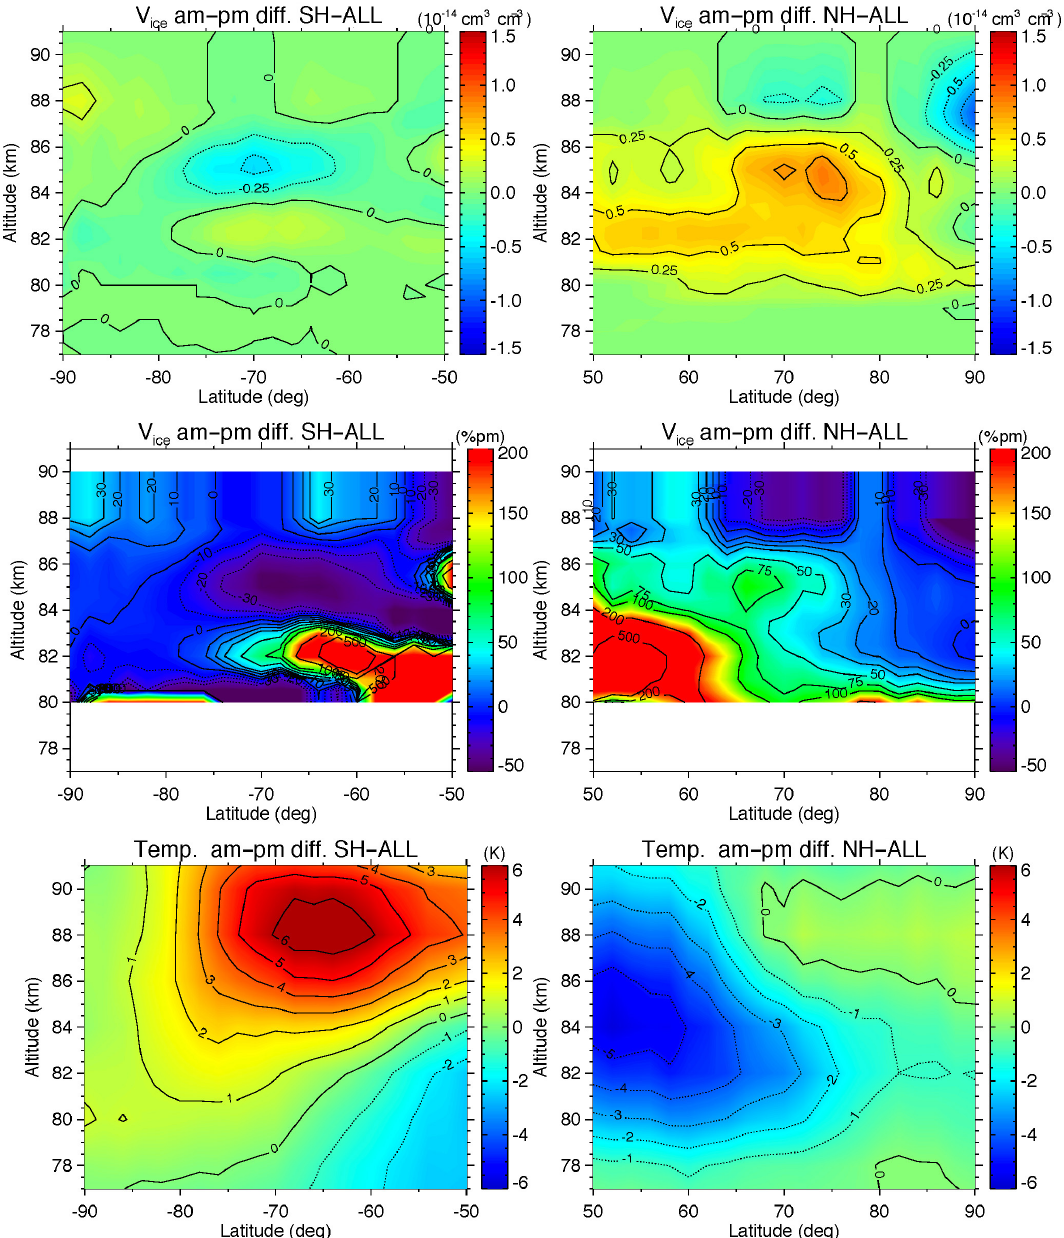
Figure 12. Top and middle panels: zonal mean morning–evening ice volume density differences (in absolute and % of pm, respectively) for the SH (left) and NH (right). Bottom panels: zonal mean morning–evening temperature differences as measured by MIPAS for the SH (left) and NH